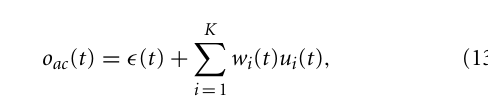
randomly selected recurrent neurons. It can be clearly observed that the driving input signal clamps the activity of the network at 200ms however different neurons decay with varying timescale. As a result the network exhibits considerable fading memory of the brief incoming input